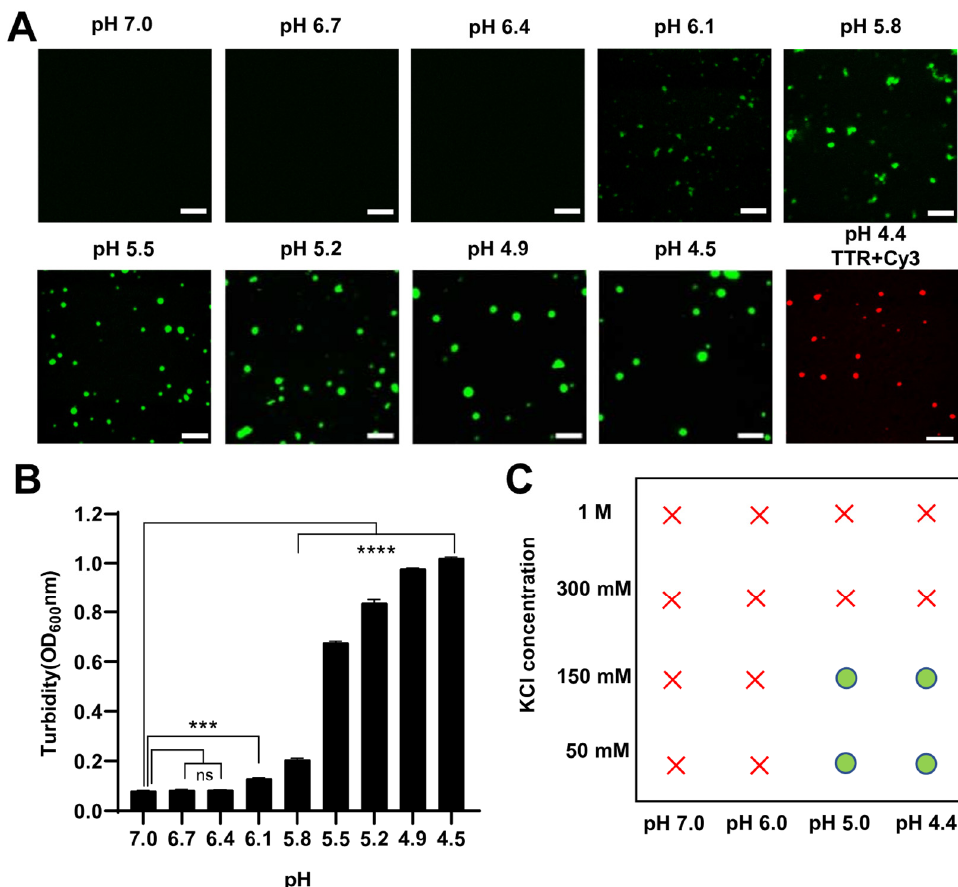
Figure 1. TTR forms phase separation under acidic conditions. ( A ) Confocal microscope of 10 µ M EGFP-TTR at various pHs and Cy3 staining of 10 µ M TTR at pH 4.4. Scale bar, 2.5 µ m. ( B ) Turbidity of 10 µ M EGFP-TTR solution at various pHs. Error bars represented SEM (n = 3). **** p ≤ 0.0001, *** p ≤ 0.001, ** p ≤ 0.01, * p ≤ 0.05. The p values for 10 µ M EGFP-TTR at pH 6.7 ( p = 0.9996), pH 6.4 ( p = 0.9994), pH 6.1 (*** p = 0.0002), pH 5.8 (**** p < 0.0001), pH 5.5 (**** p < 0.0001), pH 5.2 (**** p < 0.0001), pH 4.9 (**** p < 0.0001) and pH 4.5 (**** p < 0.0001) were calculated with respect to pH = 7.0. ( C ) The regime diagram illustrated the phase separation of 10 µ M EGFP-TTR at varying pH and salt concentrations. The green dot indicated droplets. The red “ × ” indicated no phase